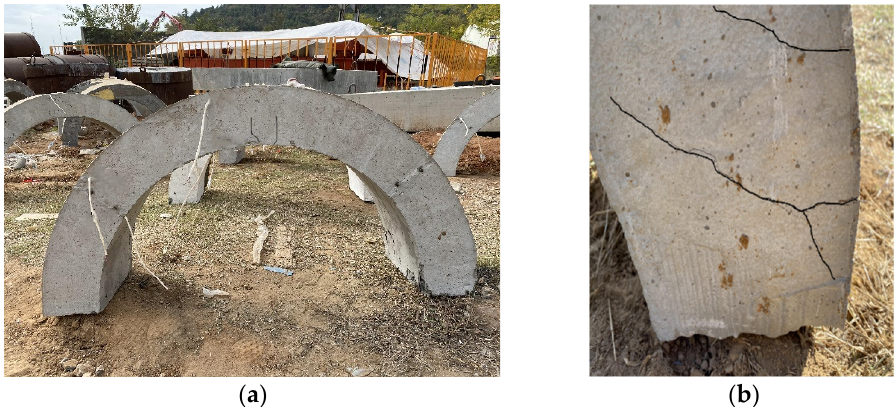
Figure 5. Macroscopic damage to the blast-loaded arches: ( a ) two cracks of the inner side of the vault, and ( b ) shear cracks at arch foot.